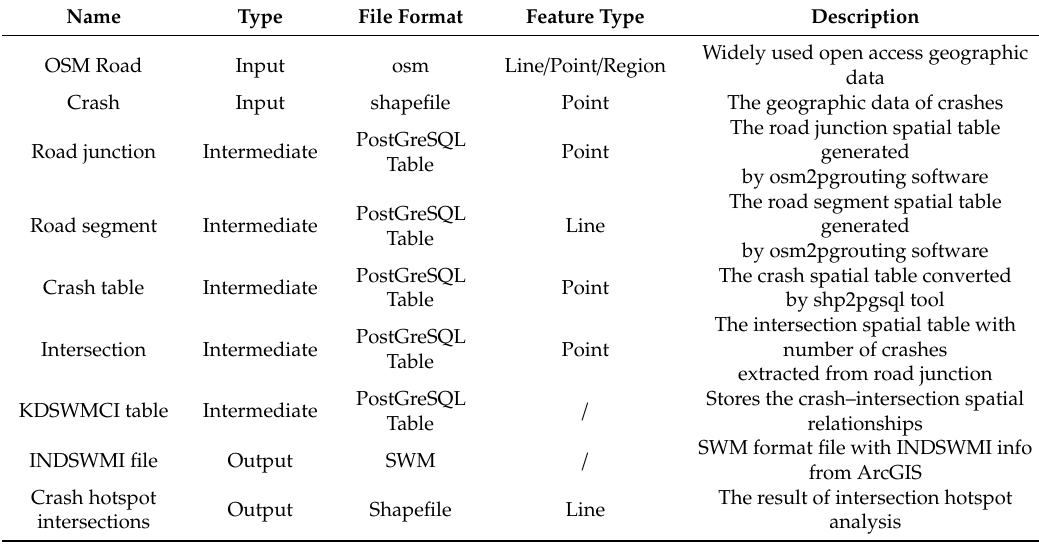
Table 1. An overview of data